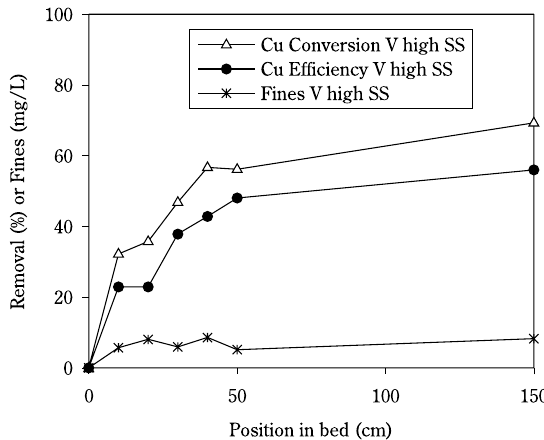
Fig. 8 Copper concentration in the reactor as a function of position in the